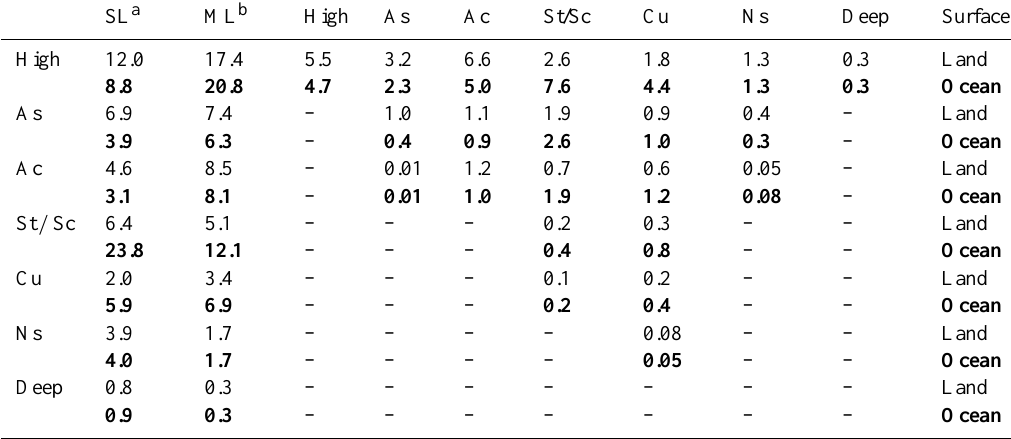
Table 2. Globally averaged overlapping percentages for different cloud types over land and ocean during nighttime. SL a ML b High As Ac